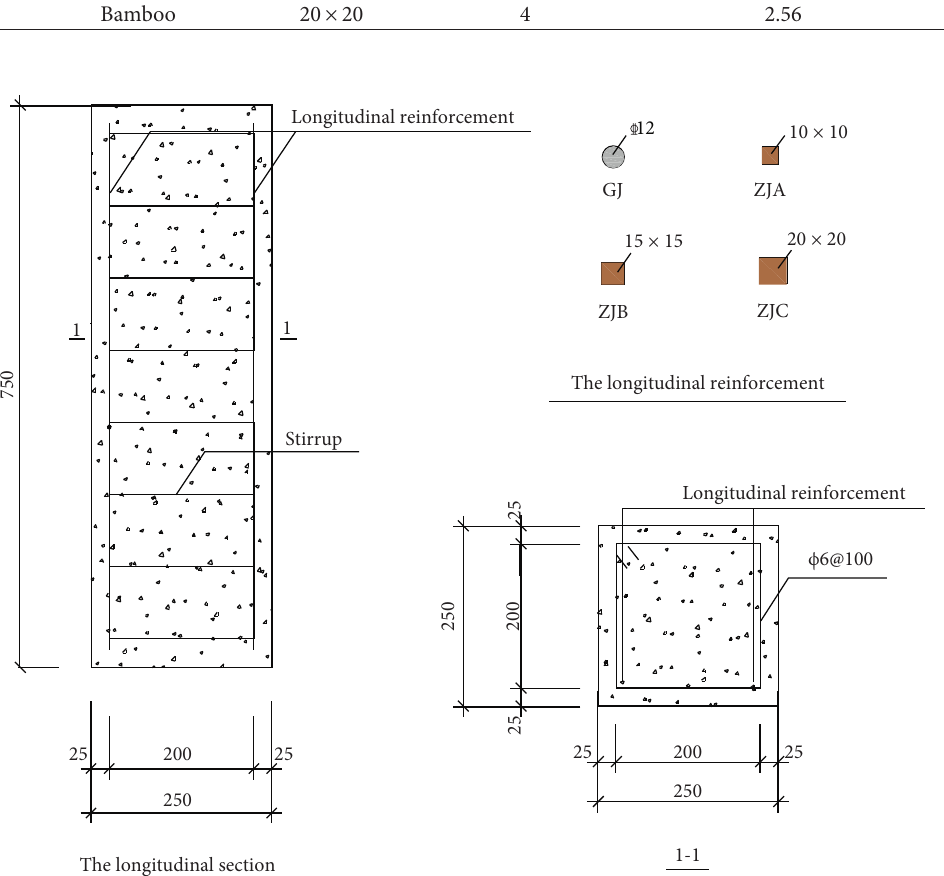
Figure 1: Details of specimens (all dimensions are in mm).